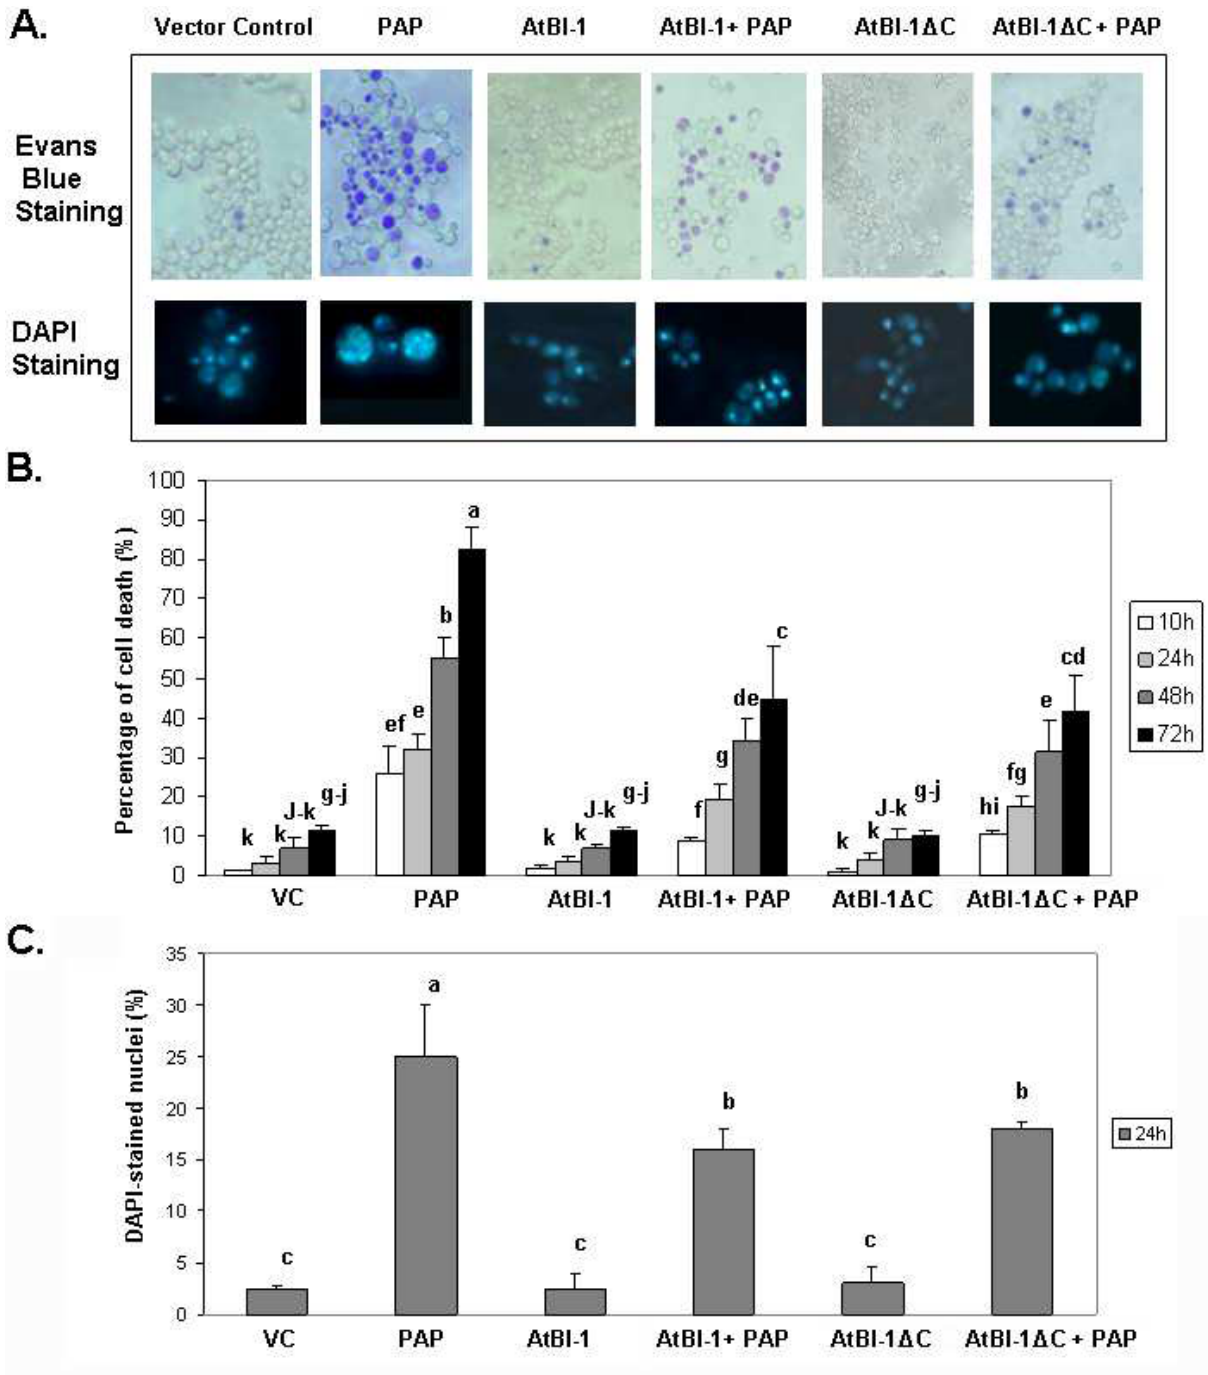
FIGURE 1: Analysis of cell death and nuclear fragmentation in yeast cells expressing PAP, AtBI-1 and AtBI-1ΔC . (A) Cells were stained with Evans Blue or DAPI at 24 h after induction and visualised using Zeiss Axiovert 200 inverted microscope (magnification, X 40) nuclei are shown enlarged 40 times relative to the yeast cells. (B) The percentage of the cell death at different hours after induction were quantified and are represented as the means ± standard deviation (n=3). (C) DAPI stained nuclei at 24 h post-induction were quantified and are repre- sented as the means ± standard deviation (n=3). At least 100 cells were counted per experiment. The results represent three independent experiments. VC - vector control. Columns are statistically different according to ANOVA (P < 0.001) followed by a post-hoc Fisher's Least Significant Difference (LSD)